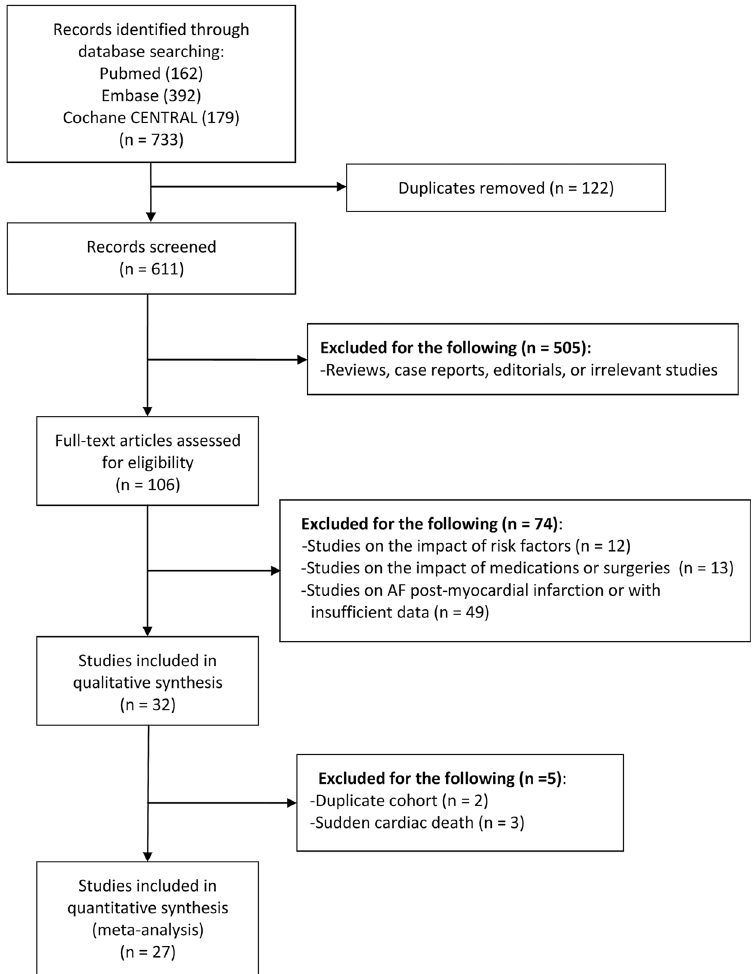
Figure 1. Flow diagram showing the study selection